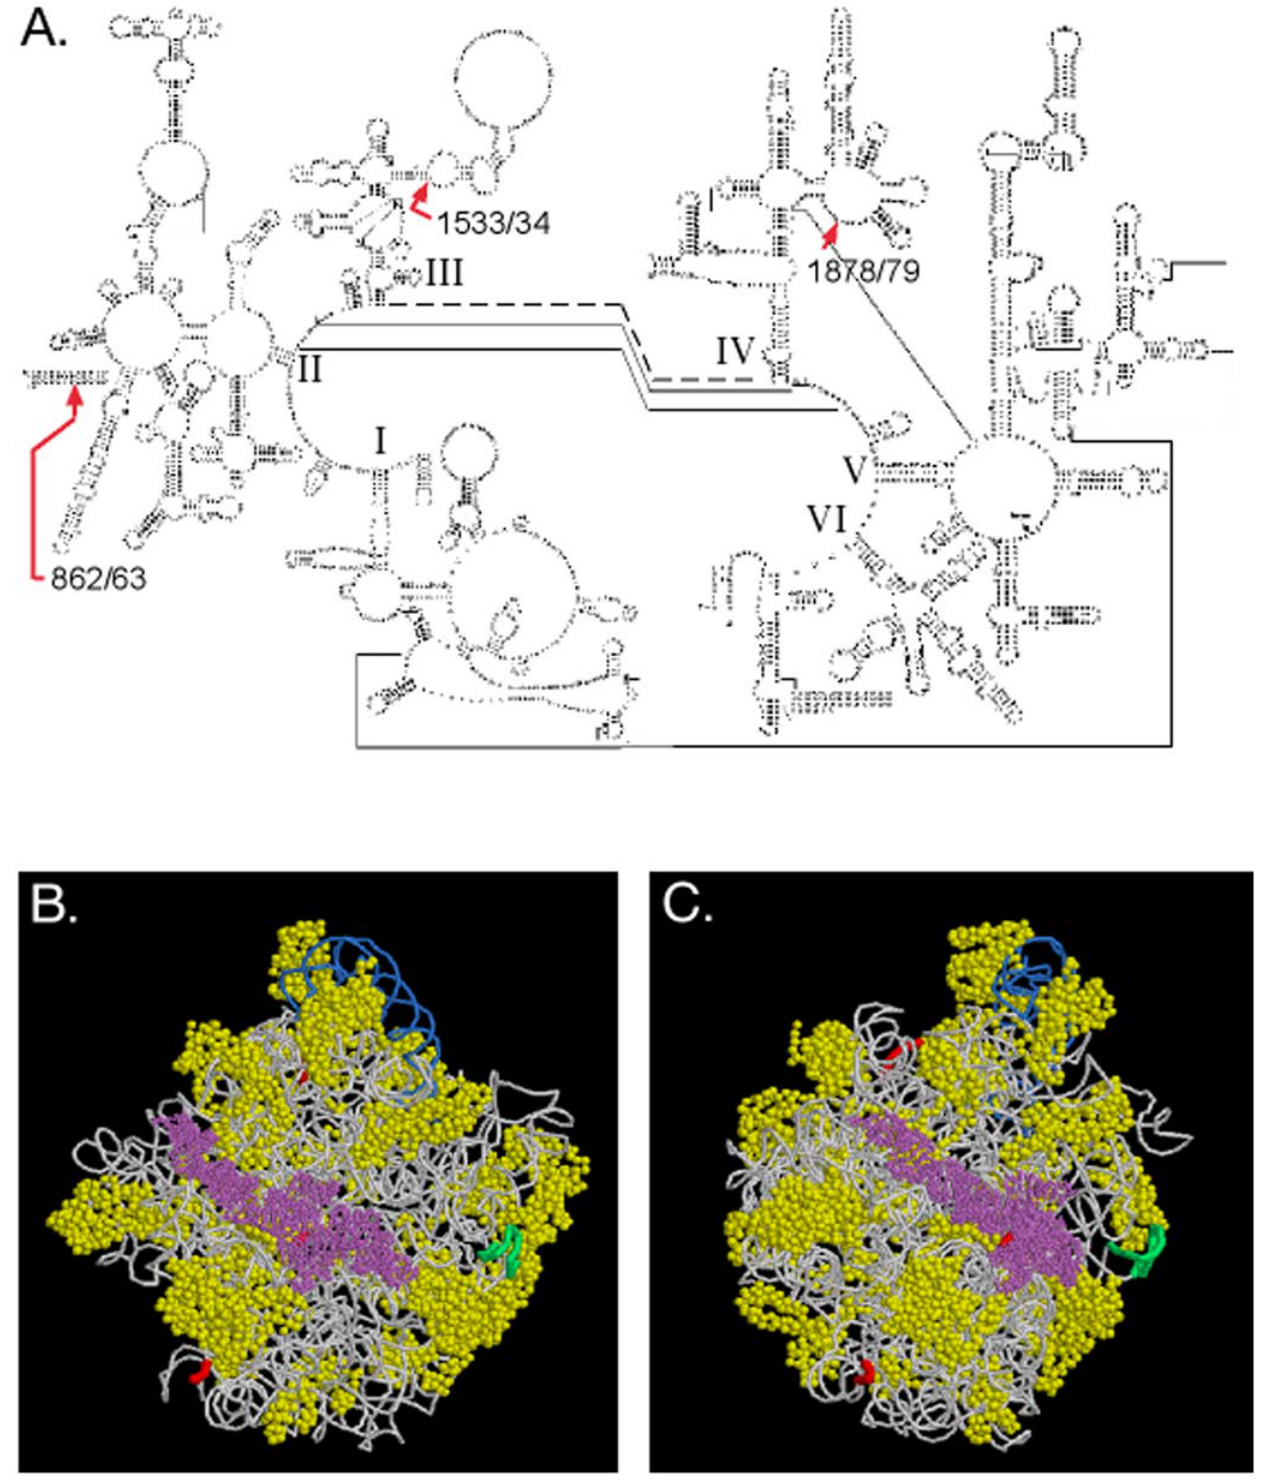
Figure 4. Location of the cleavage sites on the D.discoideum mitochondrial LSU rRNA structure. (A) Predicted secondary structure of D. discoideum mitochondrial LSU rRNA showing the locations of the cleavage sites (red arrows). For clarity, the rRNA is split between domains III and IV and the thick dashed line indicates the covalent linkage between the two halves. Lines indicate predicted basepairs in the three dimensional structure between bases that widely separated in the primary sequence. The domains are labeled in roman numerals near where their secondary structure emanates from the center. (B) LSU rRNA cleavage sites (red) mapped onto the three-dimensional structure of the Haloarcula marismortui mitochondrial ribosome (pdb 1ffk). The LSU rRNA (grey line), the 5S rRNA (blue line) and ribosomal proteins (yellow) are shown. The rRNA sarcin/ricin loop is indicated (green). The points of contact with the small subunit (purple) in domain IV of the rRNA secondary structure are where essential ribosomal functions are carried out and where the cleavage site at base 1878 is located (red). (C) Predicted structure in B rotated 60 degrees counterclockwise on the vertical axis.